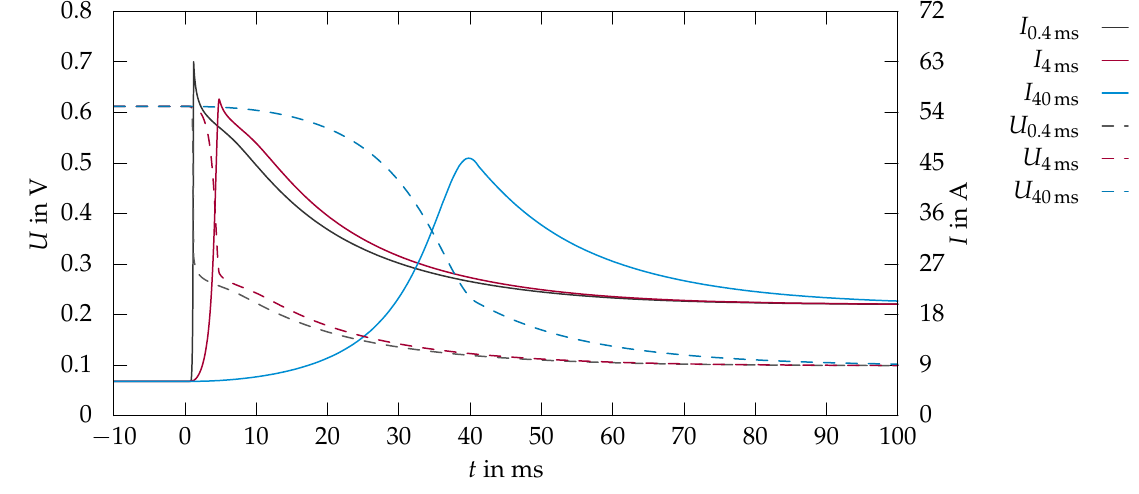
Figure 17. Current (solid) and voltage (dashed) in the transient simulation of the SC with a variation of the current rise time at a stationary load of 0.1 Ω prior to the